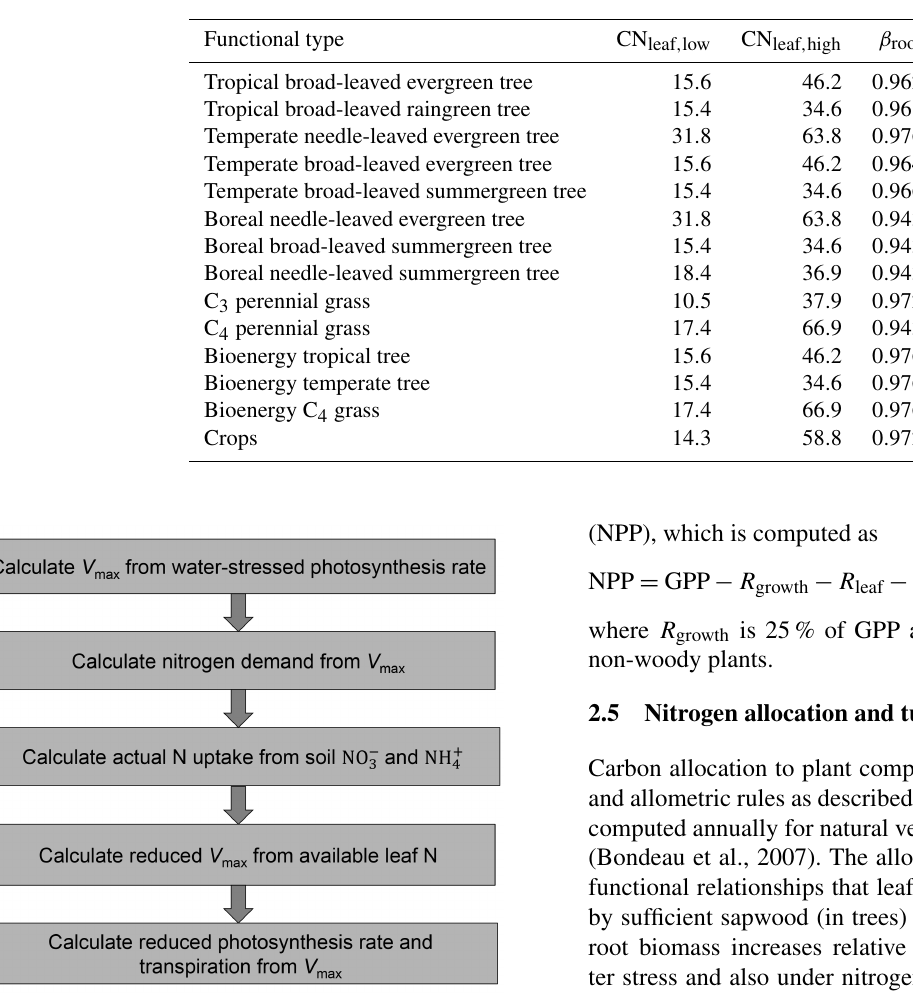
Table 2. PFT-specific β root based on Schaphoff et al. (2018b) and minimum and maximum leaf C:N ratios based on the TRY database (Kattge et al., 2011) with data from Kurokawa and Nakashizuka (2008), Garnier et al. (2007), Penuelas et al. (2010a, b), Fyllas et al. (2009), Loveys et al. (2003), Han et al. (2005), Ordonez et al. (2010), Atkin et al. (1999), White et al. (2000), Xu and Baldocchi (2003), Freschet et al. (2010a, b), Laughlin et al. (2010), Niinemets (2001, 1999), Willis et al. (2010), Baker et al. (2009), Patiño et al. (2009), Pakeman et al. (2009, 2008), Fortunel et al. (2009), Cornelissen et al. (1996, 1997, 2004), Quested et al. (2003), Sardans et al. (2008b, a), and Ogaya and Penuelas (2003, 2006, 2007, 2008). The C:N ratios for C 3 and C 4 grasses and crops are based on White et al. (2000).